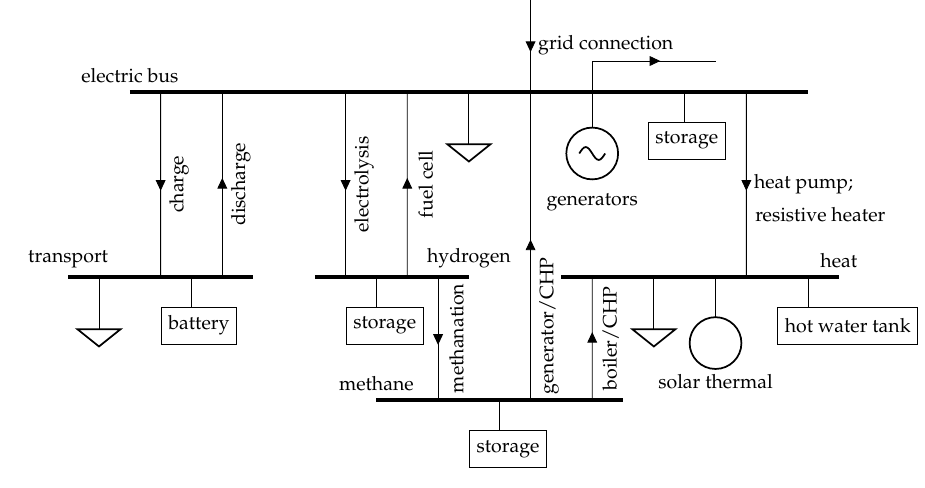
Figure 1. Costs by country with zero CO 2 emissions and optimal transmission. The colour assignments follow Figure 3.